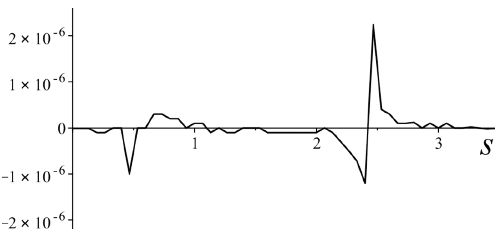
Figure 11. Conservation law of x -momentum at t = 0.64.